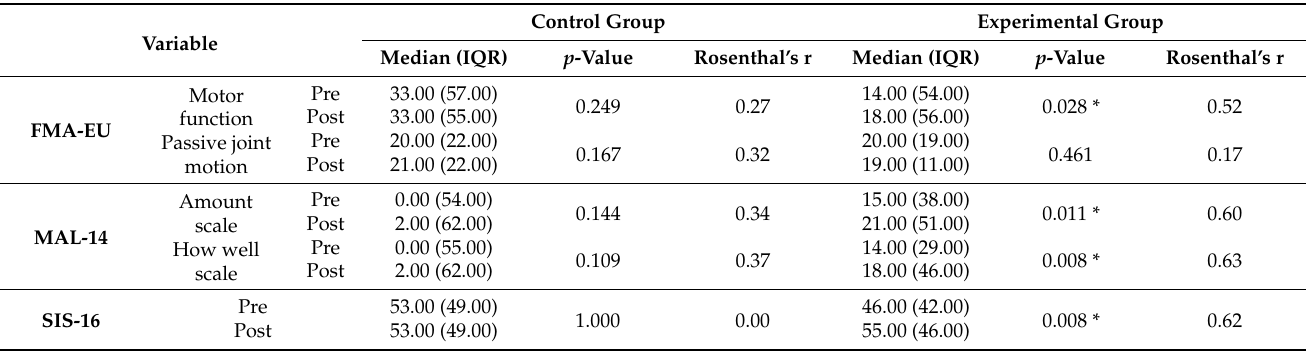
Table 3. Motor and functional assessment pre- and post-treatment in control and experimental group. Intragroup